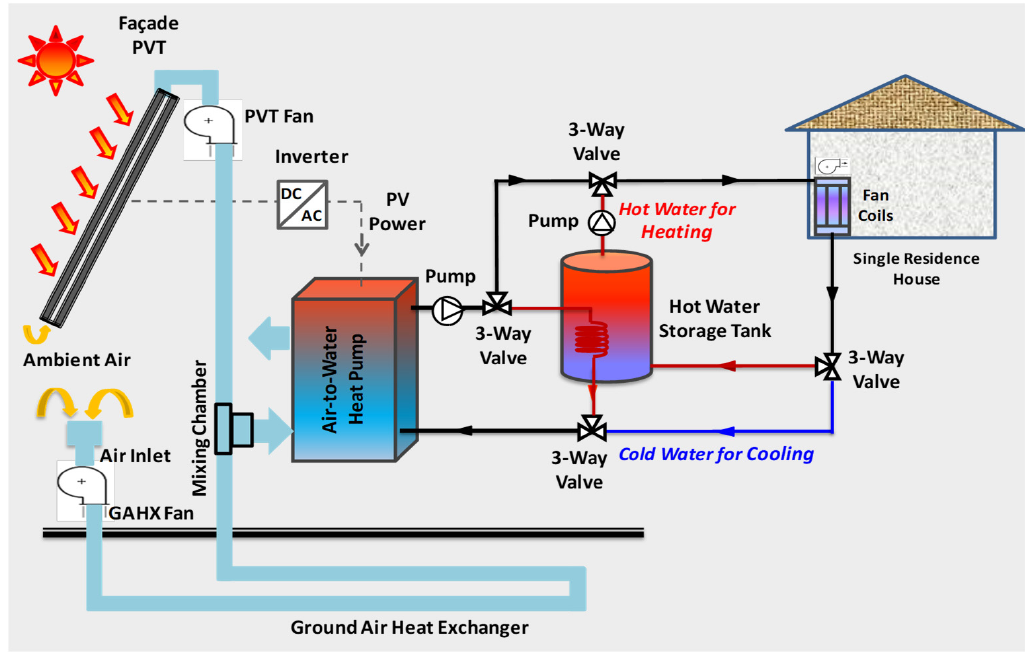
Figure 1. Trigeneration Renewable System schematic.